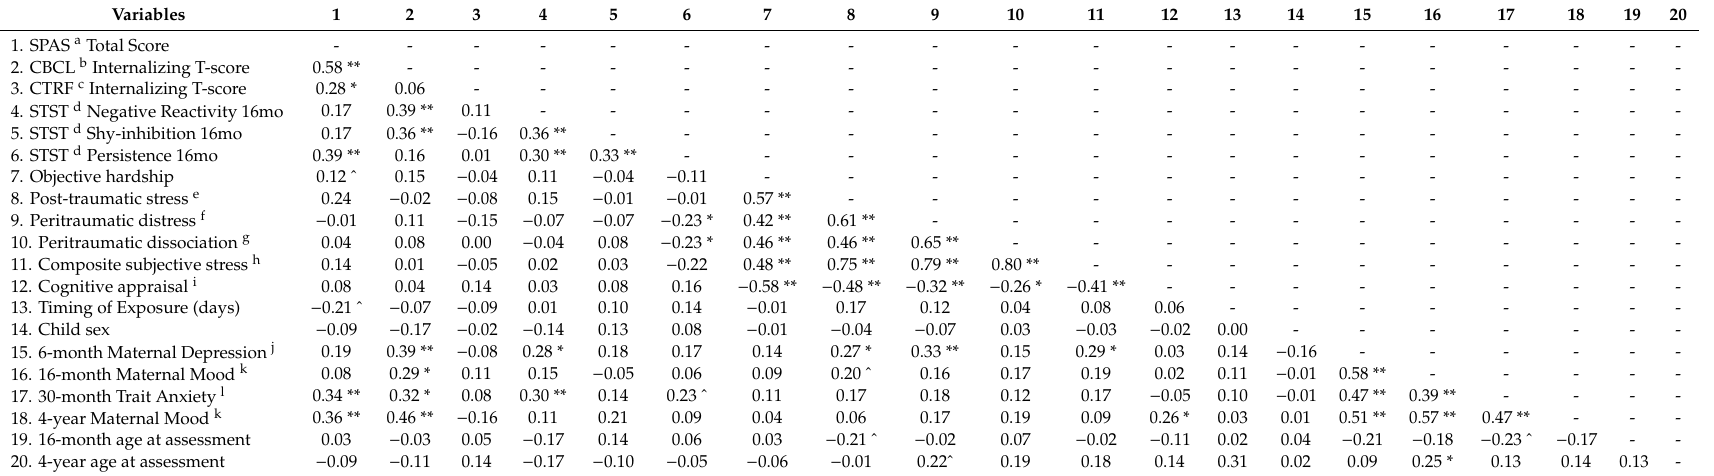
Table 3. Pearson’s correlations between study variables for the teacher-report sample ( N =